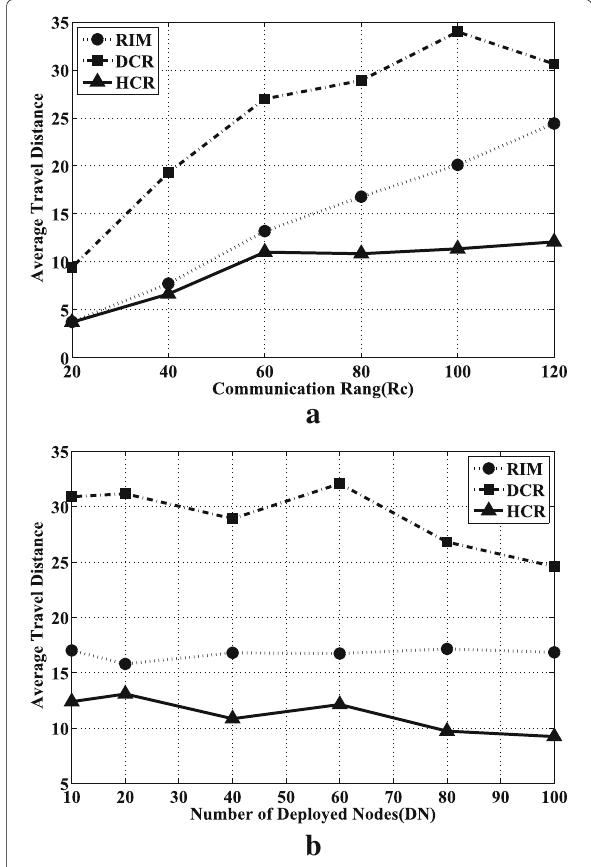
Fig. 11 The average distance a node travels during the restoration while varying a the communication range (with DN = 40), and b the network size (with R c = 80)